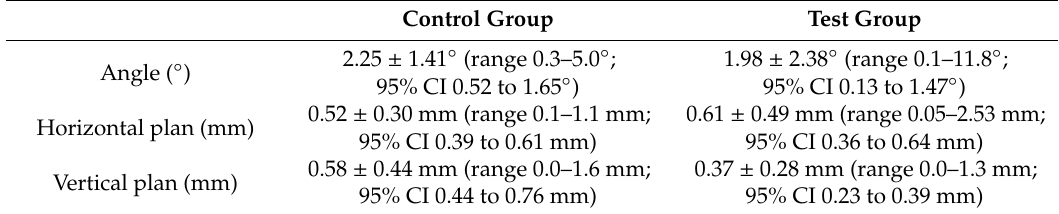
Table 1. Analysis of the final implant accuracy.